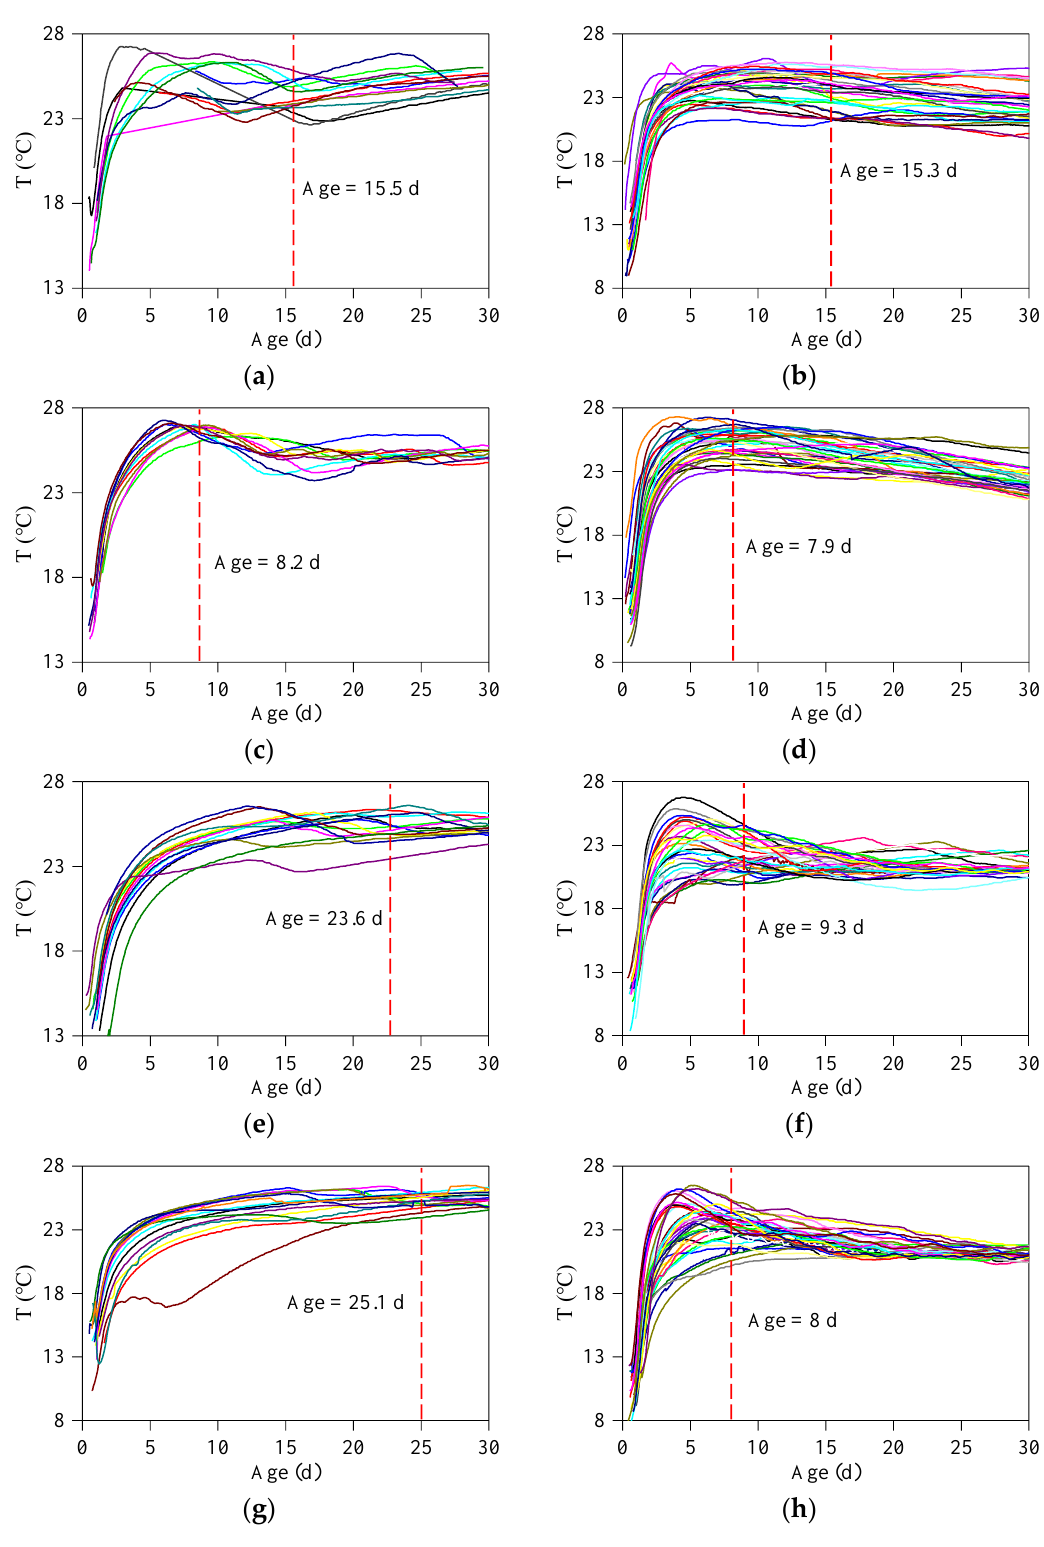
Figure 11. The temperature change curves of WDD concrete blocks: ( a ) July 2017; ( b ) July 2019; ( c ) August 2017; ( d ) August 2019; ( e ) November 2017; ( f ) November 2019; ( g ) December 2017; ( h ) December 2019. Note: the ages in Figure 11 are the average age at which the concrete blocks reached the maximum temperature Table 6. Statistics of the highest temperature of concrete blocks of the WDD dam.